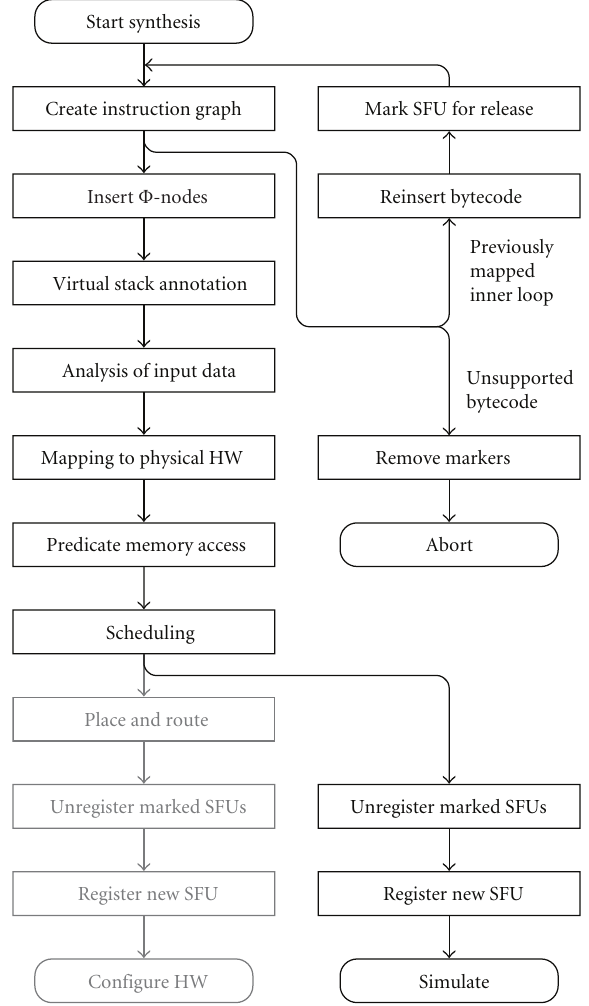
Figure 6: Overview of synthesis